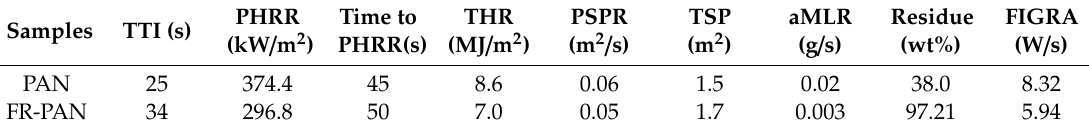
Figure 6. HRR ( a ), THR ( b ), SPR ( c ), and TSP ( d ) curves of PAN and FR-PAN fabrics. Table 1. Parameters of PAN and FR-PAN by cone calorimetry